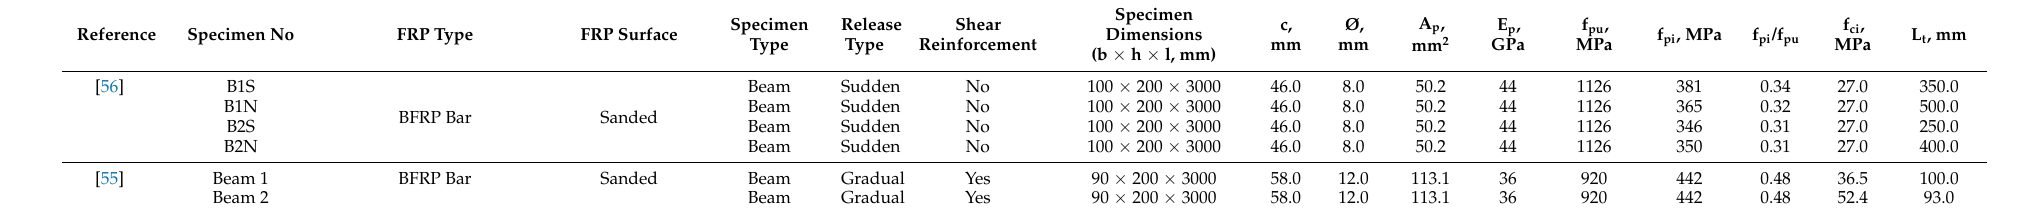
Table 5. Geometrical, mechanical properties of the material and transfer lengths of specimens with pretensioned BFRP